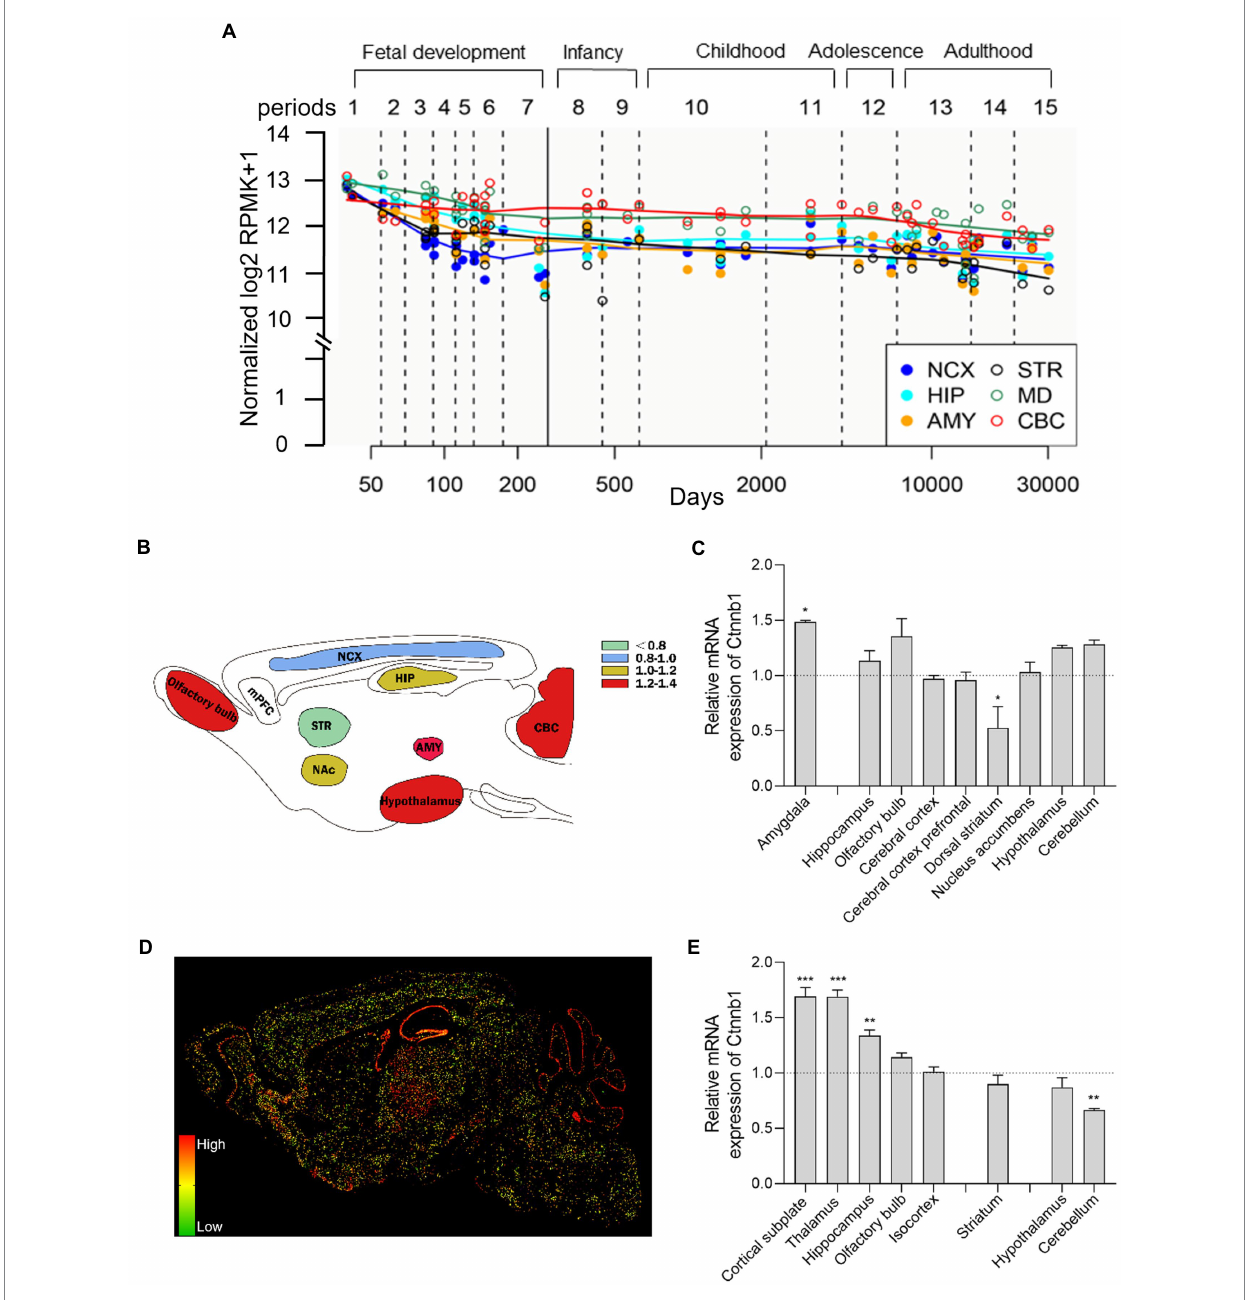
FIGURE 2 Brain-wide CTNNB1 expression and distribution. (A) Trajectory plot showing the expression of CTNNB1 during fetal development (period 1–7), early stages (period 8–9), youth (period 10–11), puberty (period 12), and adulthood (period 13–15) from different brain regions in human: NCX (the neocortex), HIP (hippocampus), AMY (amygdala), STR (striatum), MD (mediodorsal nucleus of the thalamus), and CBC (cerebellar cortex). Reprinted and modified from Human Brain Transcriptome dataset (https://hbatlas.org/, search gene Ctnnb1). (B,C) Schematic illustration and bar graph of Ctnnb1 expression in different brain regions of mice by using high-throughput gene expression profiling. Data obtained from BioGPS (http://biogps. org/#goto=welcome, search gene Ctnnb1). (D,E) The sagittal section and bar graph of the in-situ hybridization of Ctnnb1 mRNA signals in mice, obtained from Allen Institute ISH data (https://mouse.brain-map.org/, experiment 196, 197, 79904258). One–Way ANOVA with Holm-Sidak’s multiple comparisons test compared to whole-brain average expression, *** p < 0.001, ** p < 0.01, * p <